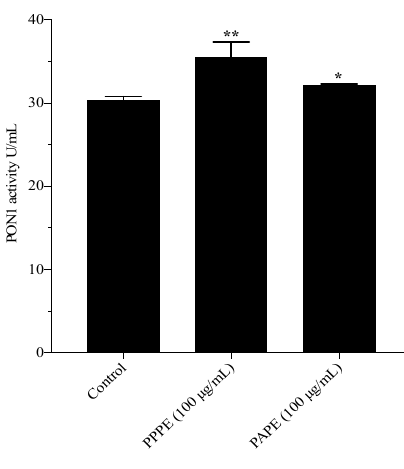
Figure 3. Pomegranate polyphenols improve PON1 activity. PON1 activity was measured in PPPE- or PAPE -enriched (80 μ g/mL) plasma for 2 h. Results are expressed as the means ± sem of three independent assays. * p < 0.05, ** p < 0.01 and indicate significant differences compared to the control.